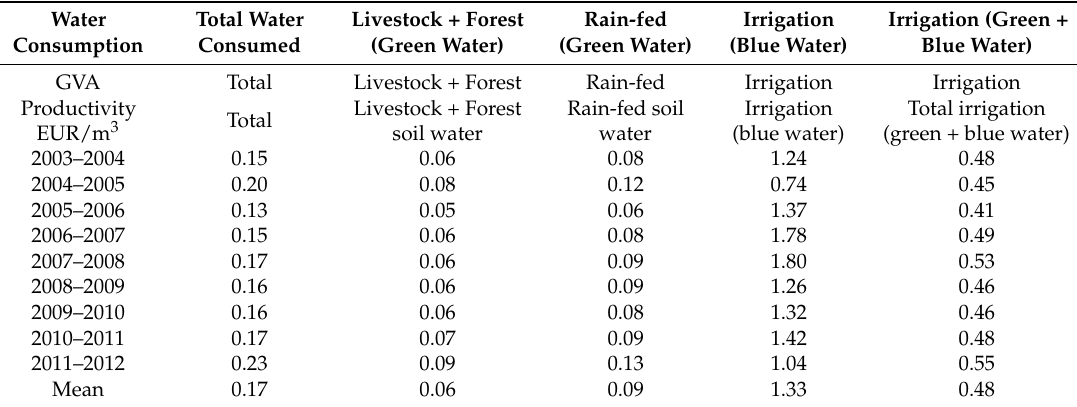
Table 5. Apparent productivity of water in the Guadalquivir River Basin